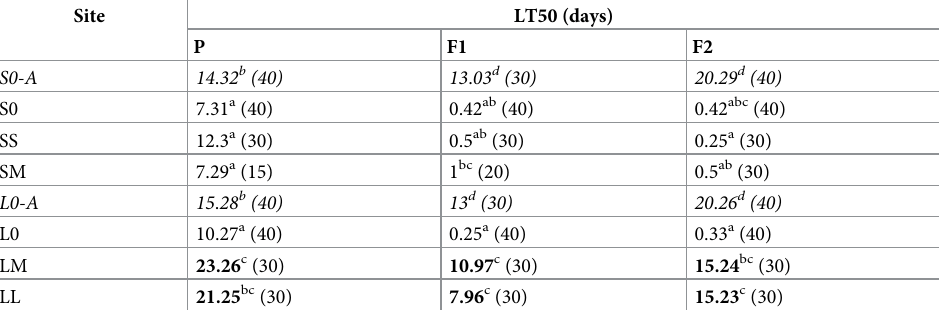
Table 3. Median lethal times (LT50, days) for all three generations (P–Parental, F1, F2 –Laboratory bred) from all habitat